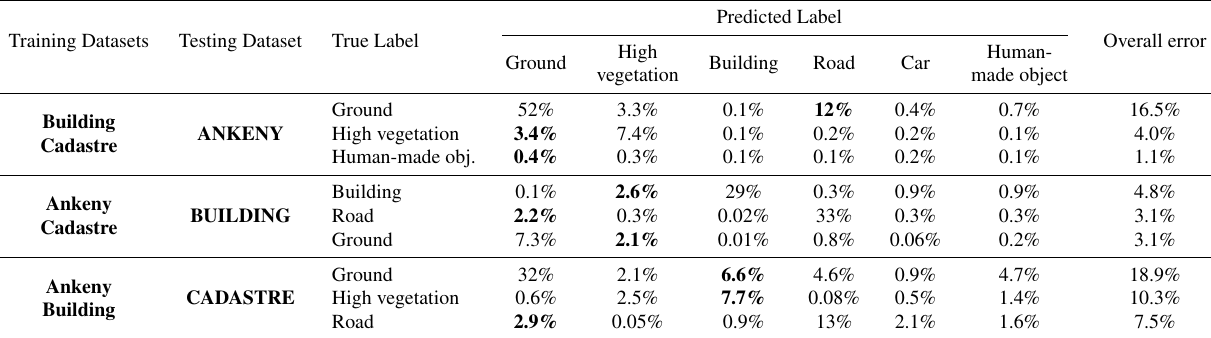
Table 5. Confusion matrix for the top-3 misclassified classes. In bold we highlighted the misclassification error corresponding to the class with which the true label is confused the most. Results obtained for the G + C N (0 . 6) features with the GBT classifier, training on two datasets and testing on the remaining third one. Percentages are with respect to the total number of points in the testing dataset. See section 4.4 for a detailed